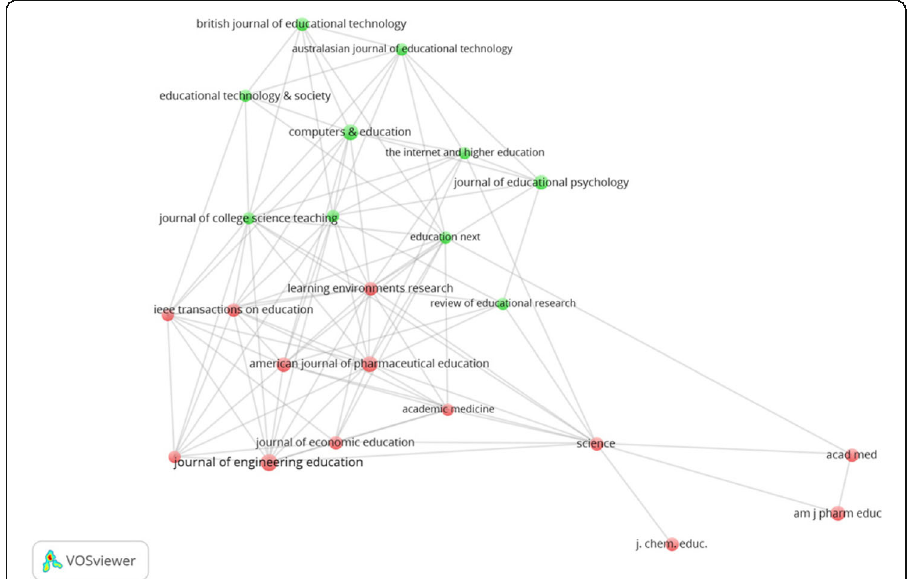
Fig. 3 Co-occurrence of citations in the corpus (green = general education and educational technology, red = subject-specific higher